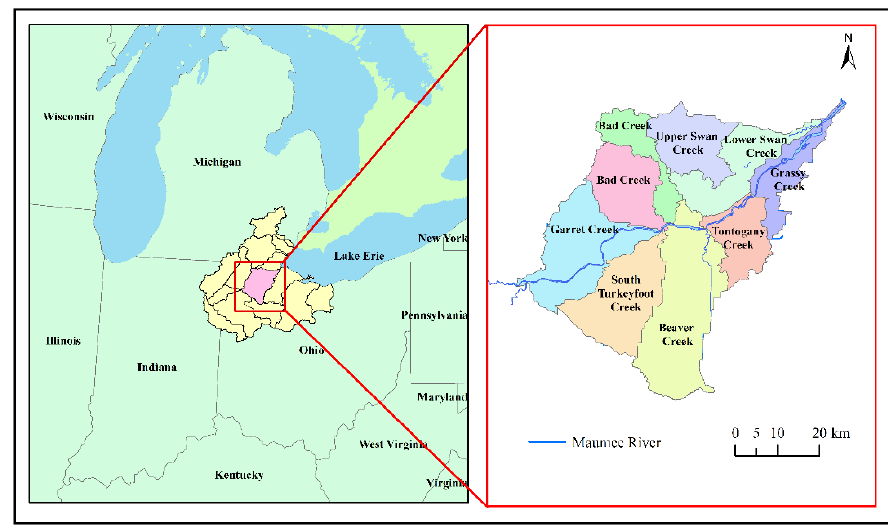
Figure 1. Location of study area—The Lower Maumee River watershed in Ohio, USA. The watershed drains into Lake Erie (Data Source: USGS [44]).